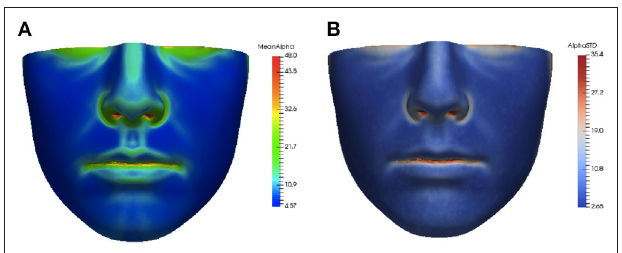
FIGURE 4 | Average (A) and standard deviation (B) of angle of surface orientation feature for the data set.